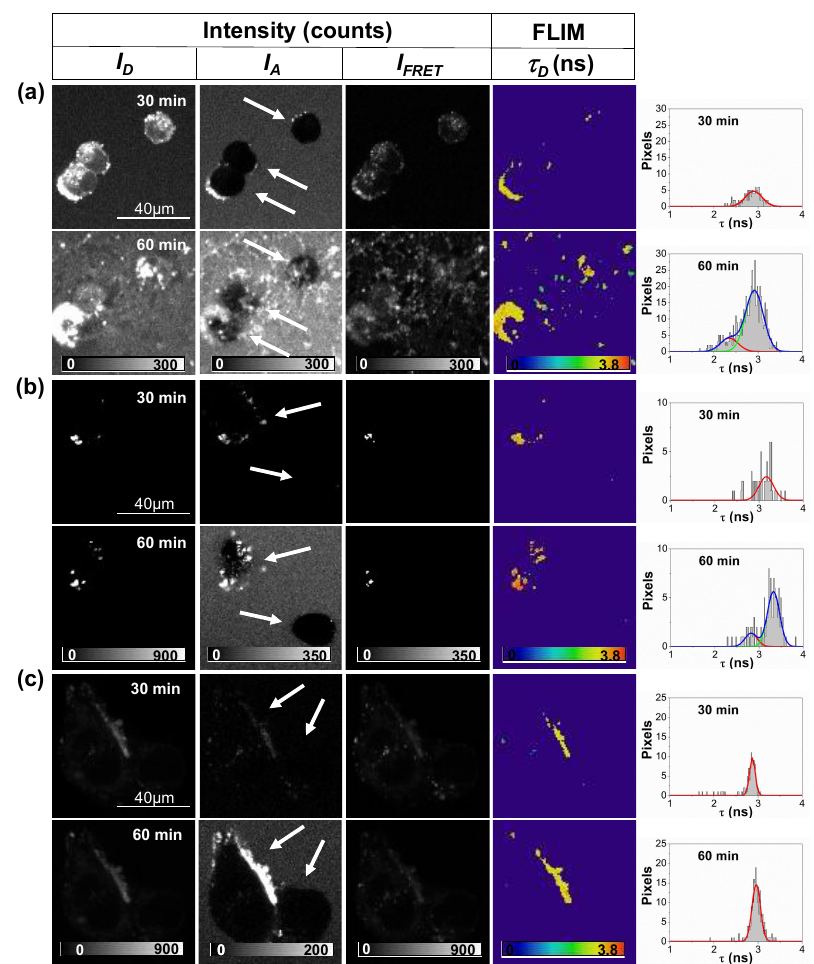
Figure 2. Fluorescence intensity images in the three detection windows ( I D , I FRET , and I A ) and FLIM images of the donor fluorophore, τ D , of equimolar mixtures of labeled A β -488 and A β -647 peptides (incubated for 15 h) interacting with Neuro-2a (N2a) cells for 30 and 60 min. Histograms in the rightmost column represent τ D distributions for only pixels selected as aggregates. The distributions were fitted to one or two (if needed) Gaussian functions (lines). Panels ( a ), ( b ), and ( c ) are representative images from different, repeated experiments. The arrows indicate different detected cells for identification purposes.